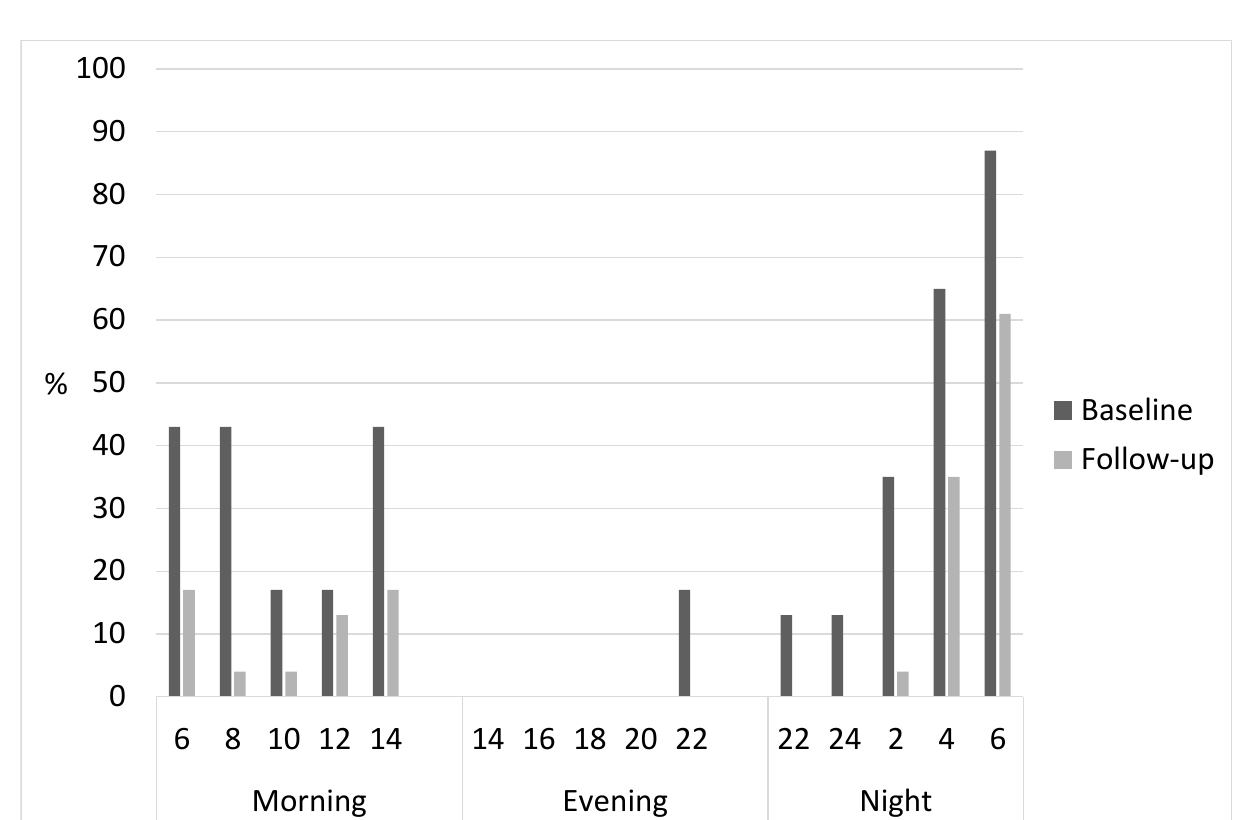
Figure 2. The shift-specific retrospective severe sleepiness (% of KSS ≥ 7) in every second hour of work shifts at the baseline and at the follow-up of the schedule change with combined Groups A and B ( n = 23).